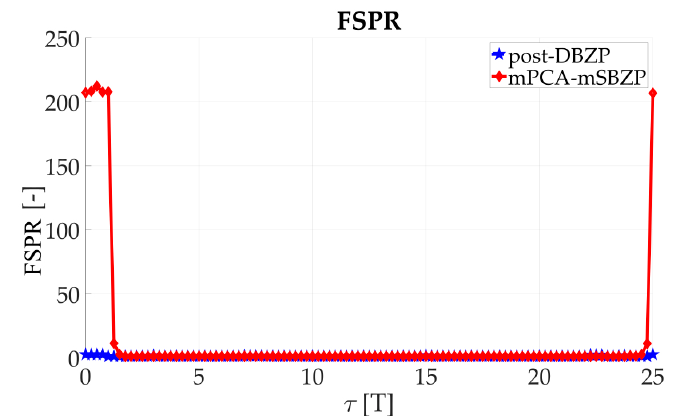
Figure 22. FSPR result of the proposed modified processing, in an entire period of SC. Figure 22 . FSPR result of the proposed modified processing, in an entire period of SC .